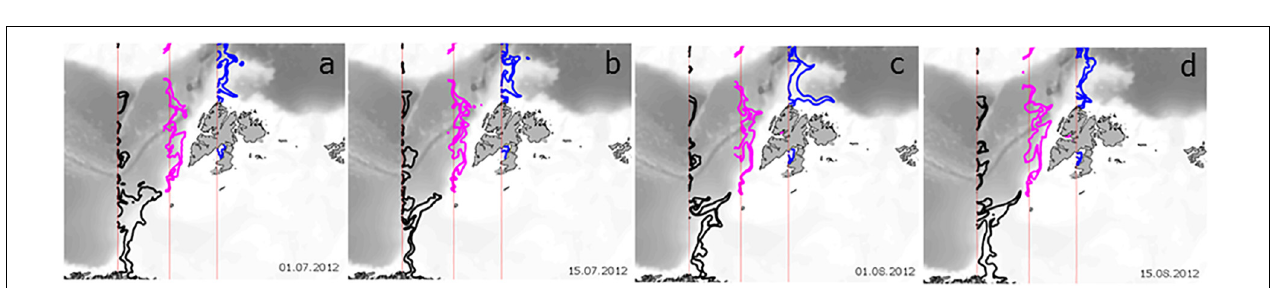
FIGURE 4 | Phytoplankton residence time (mean over 6 months, April-September. 2012) within the 4 km × 4 km × 50 m SINMOD model grid cell where lower values (blue) indicate shorter time of phytoplankton carbon biomass within the cell and higher values (red), a longer time of the phytoplankton carbon biomass within the cell. In units of days, calculated as Biomass within the grid cell/Biomass advected In.